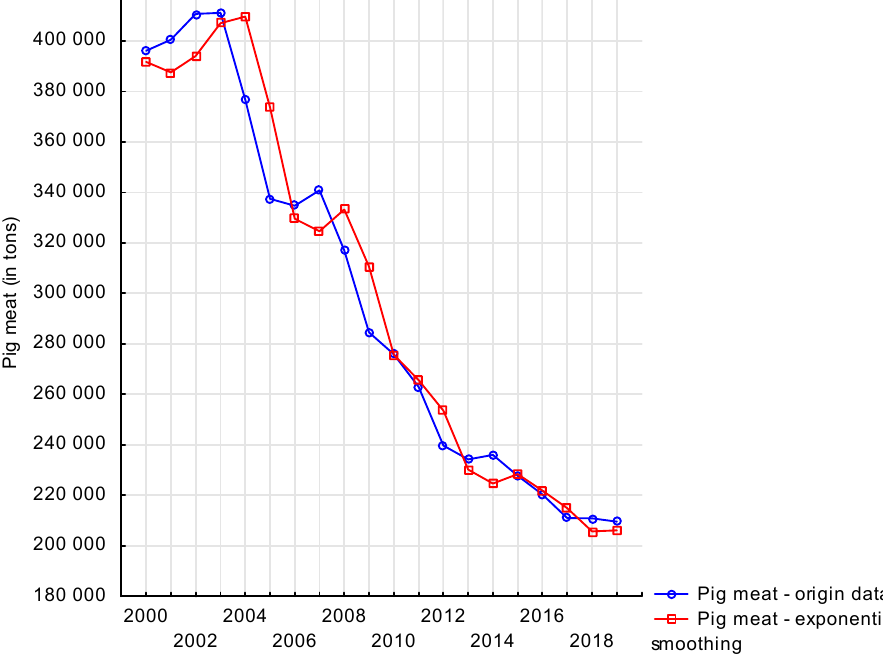
Figure 4. Pig meat production in the Czech Republic in long term time series (in tons) [27].